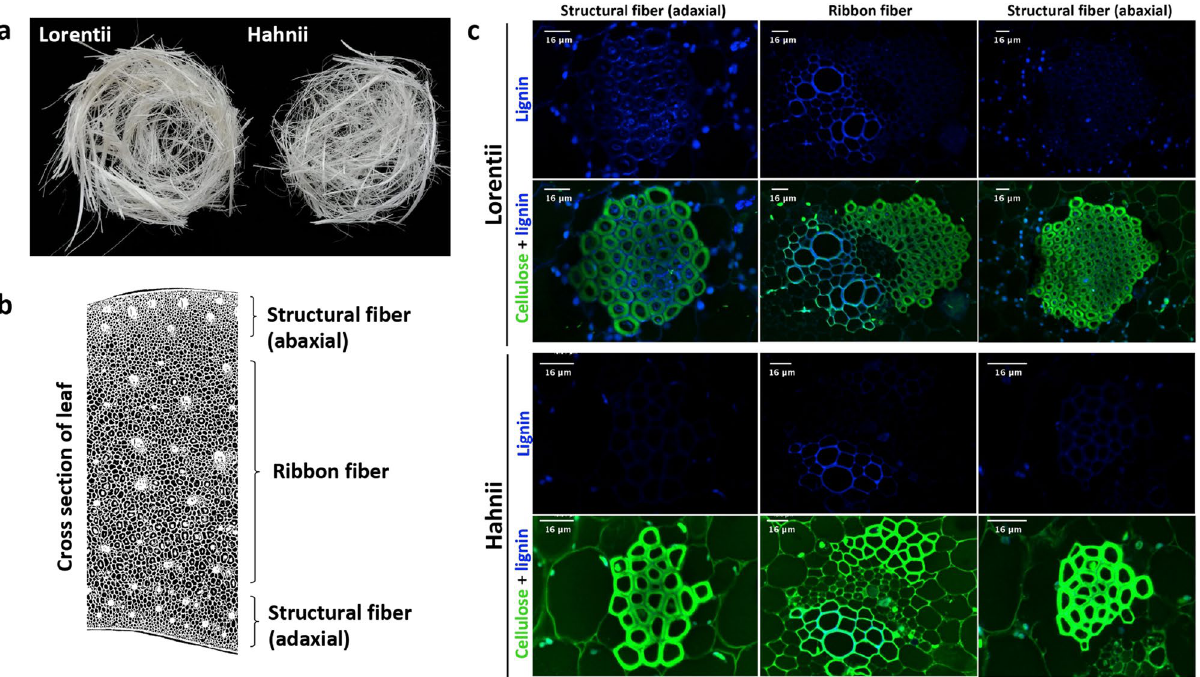
Figure 2. Fibers of the two cultivars of Sansevieria trifasciata and images of lignin and cellulose in fibers. ( a ) Crude fibers from cvs Lorentii (left) and Hahnii (right) collected from 3 or 4 adult leaves. ( b ) Micrograph-based drawing of cells in cross section of S. trifasciata adult leaf showing the distribution of the different fiber types. ( c ) Confocal laser scanning micrographs of fluorescence of lignin (autofluorescence) and cellulose (stained with propidium iodide) in the different fiber